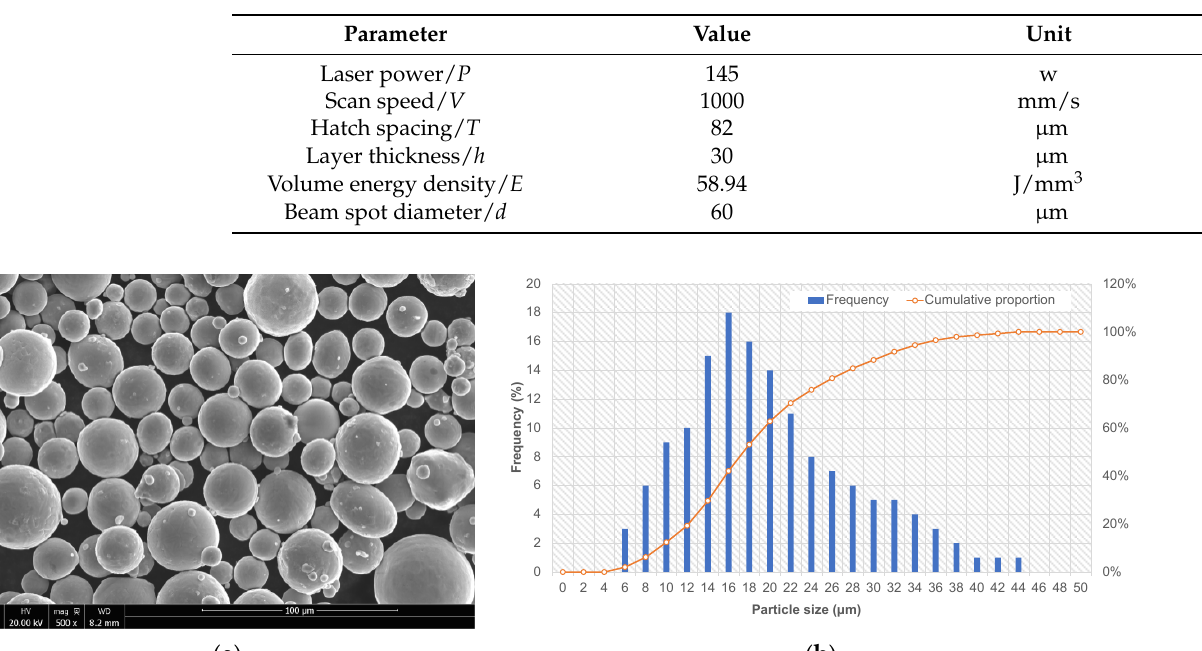
Table 2. The specific parameters in SLM.